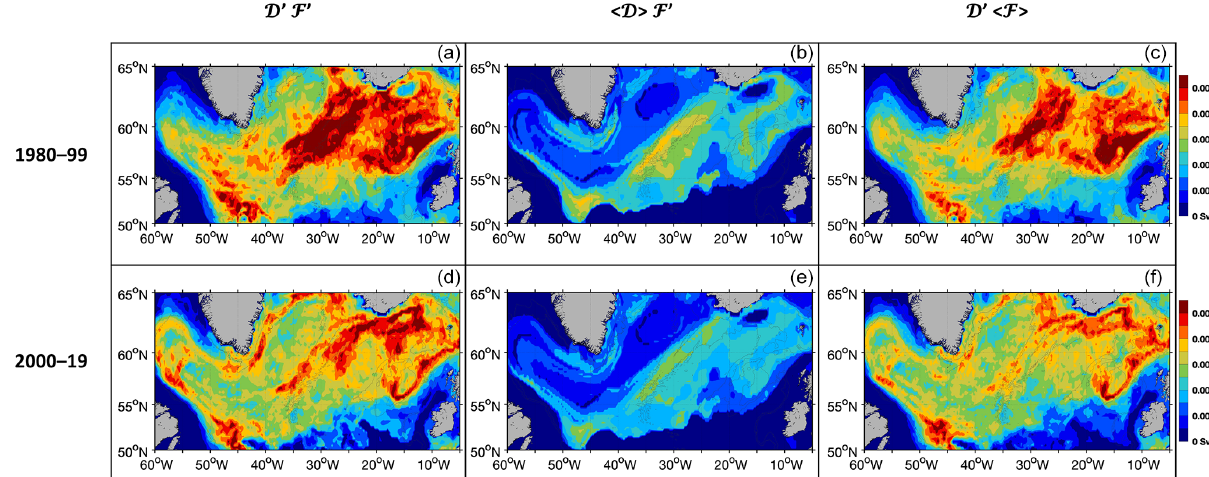
Figure 5. Same as in Fig. 4 for the density range 27.3–27.5kgm − 3 but integrated over different periods of time.